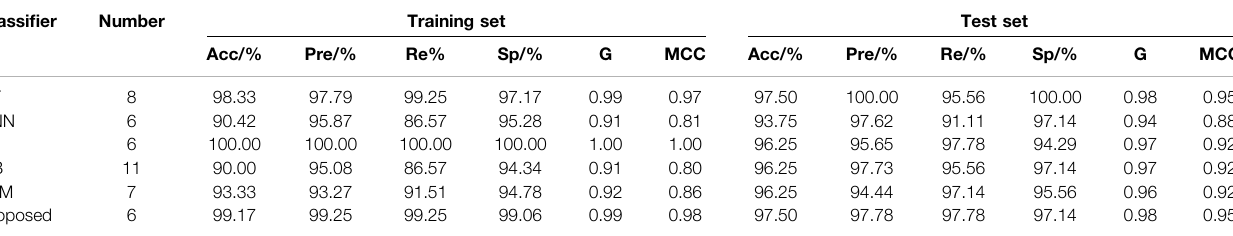
TABLE 6 | Comparison results of different classi fi ers. Classi fi er